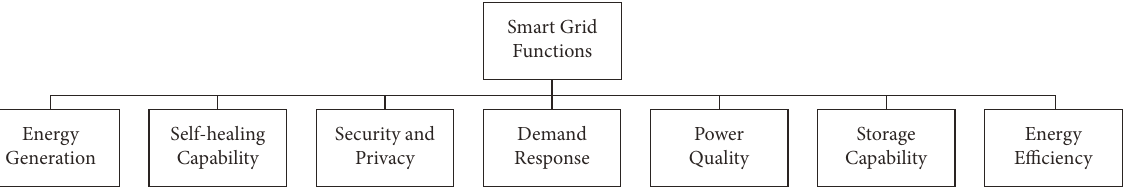
Figure 5: Functionalities of smart